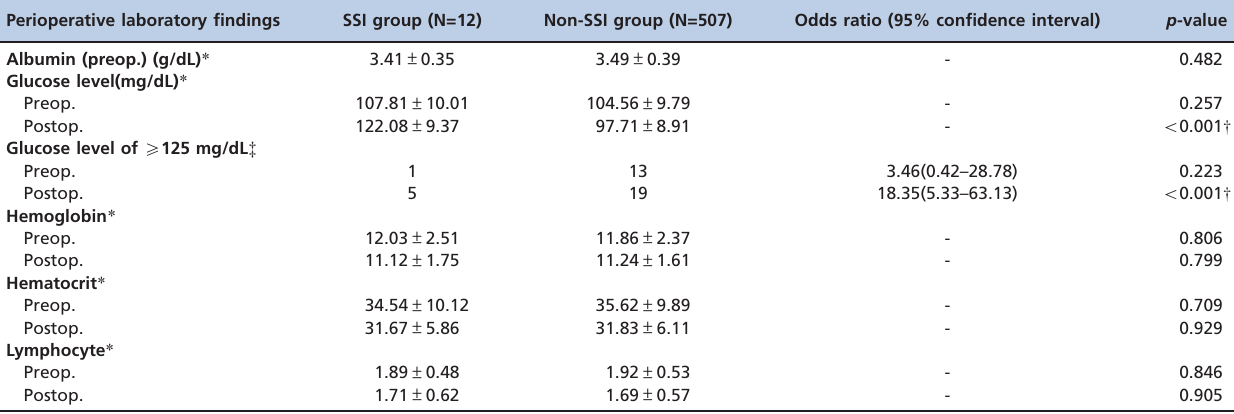
Table 2 - Comparison of laboratory findings in patients with and without surgical site infection. Perioperative laboratory